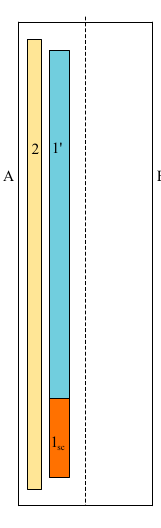
Figure 16. Windings with short circuit. Energies 2020 , 13 , x FOR PEER REVIEW